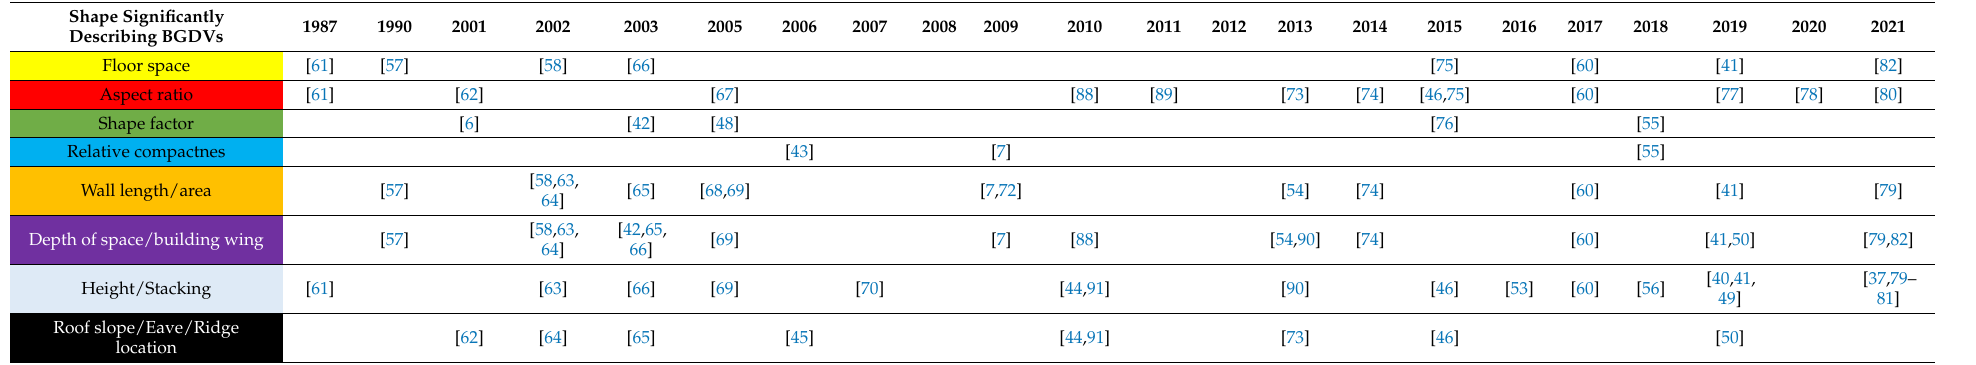
Table 3. Research focusing on frequent and significant energy performance related BGDVs in chronological